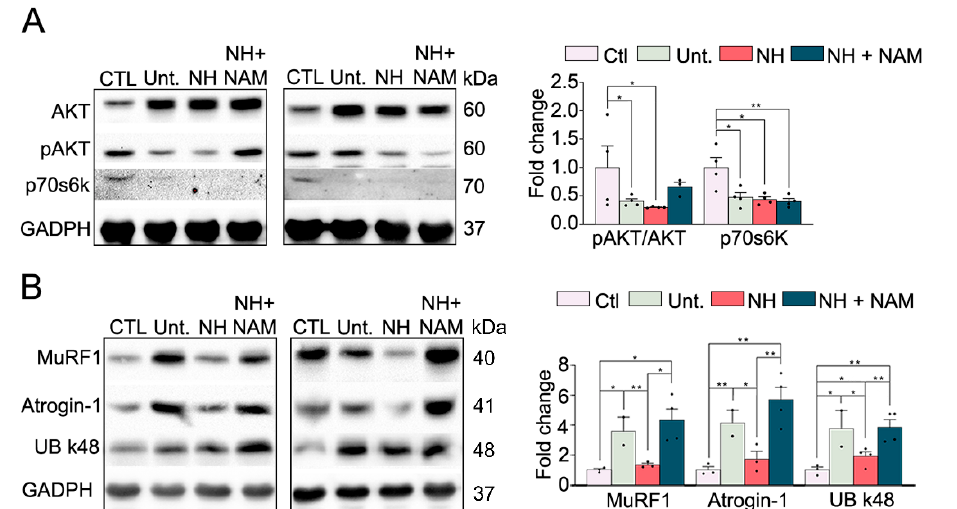
Figure 4. Ubiquitin-proteasomal degradation is modulated by NeuroHeal in the denervated muscle model. ( A ) Western blots and associated bar graphs showing the analyses of phosphorylated AKT, AKT, and pP70s6k protein levels in di ff erent experimental groups at 7 dpi (control (CTL), injured untreated (Unt.), injured treated with NeuroHeal (NH), and injured treated with NH plus nicotinamide (NAM)) ( n = 3–4; one-way ANOVA, * p < 0.05) and ( B ) Western blots and associated bar graphs showing the analyses of Atrogin-1, MuRF1, and K-48 polyubiquitin chain protein levels in di ff erent experimental groups at 7 dpi ( n = 3–4; t-test, * p < 0.05).